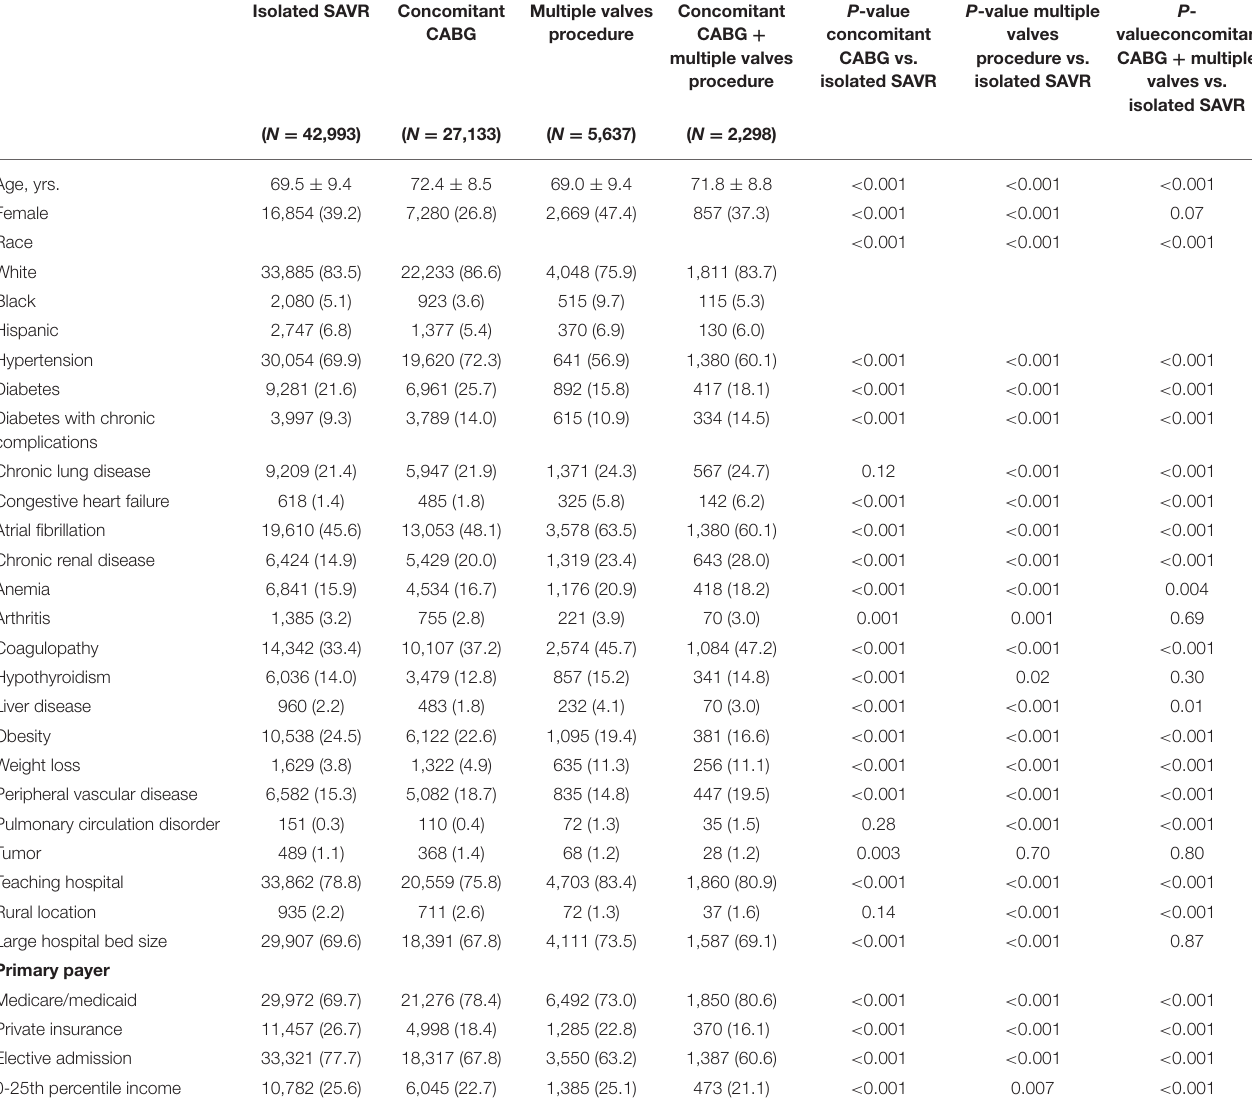
TABLE 1 | Baseline Characteristics for SAVR with or without concomitant CABG and/or multiple-valves procedure in the unmatched cohorts.